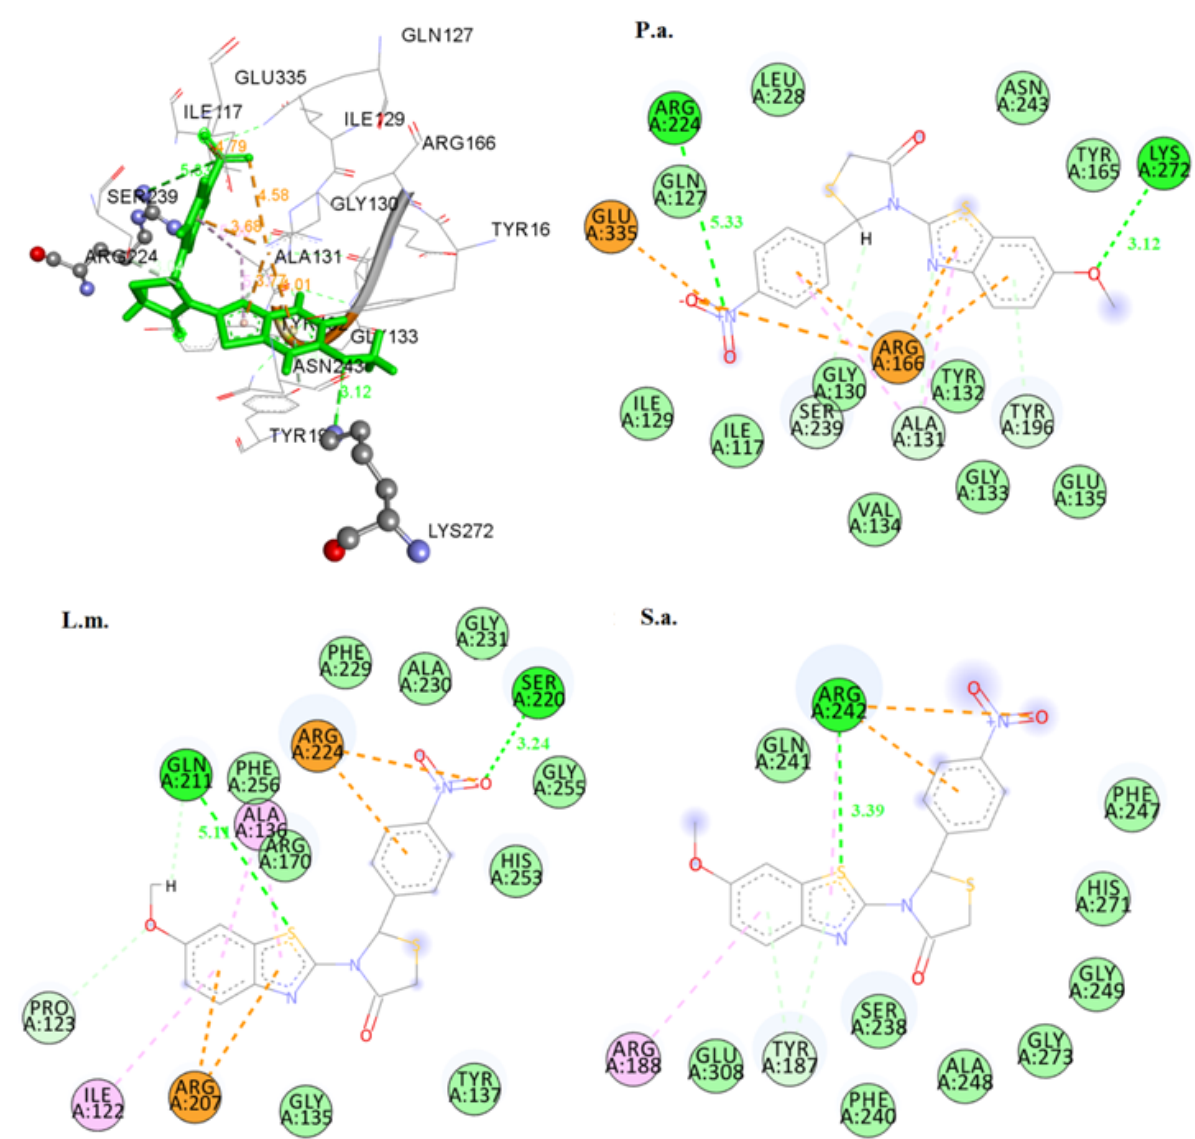
Figure 8. ( Above ) Binding pose of compound 8 (R-isomer) in the active center of MurB Pseudomonas aeruginosa (4JAY) and 2D diagram. ( Bottom ) 2D binding plots of compound 8 to the MurB enzymes of Listeria monocytogenes (3TX1) and Staphylococcus aureus (1HSK), ( left to right ).